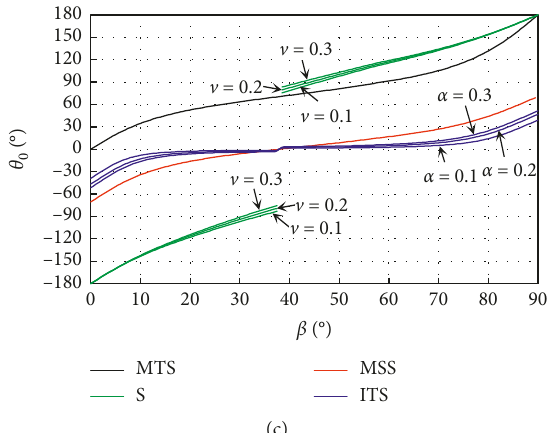
Figure 3: Relationship between crack angle and fracture angle for mixed mode I-II nonclosed crack: (a) σ ∞ (c) σ ∞ y < 0, k � − 0 . 4.